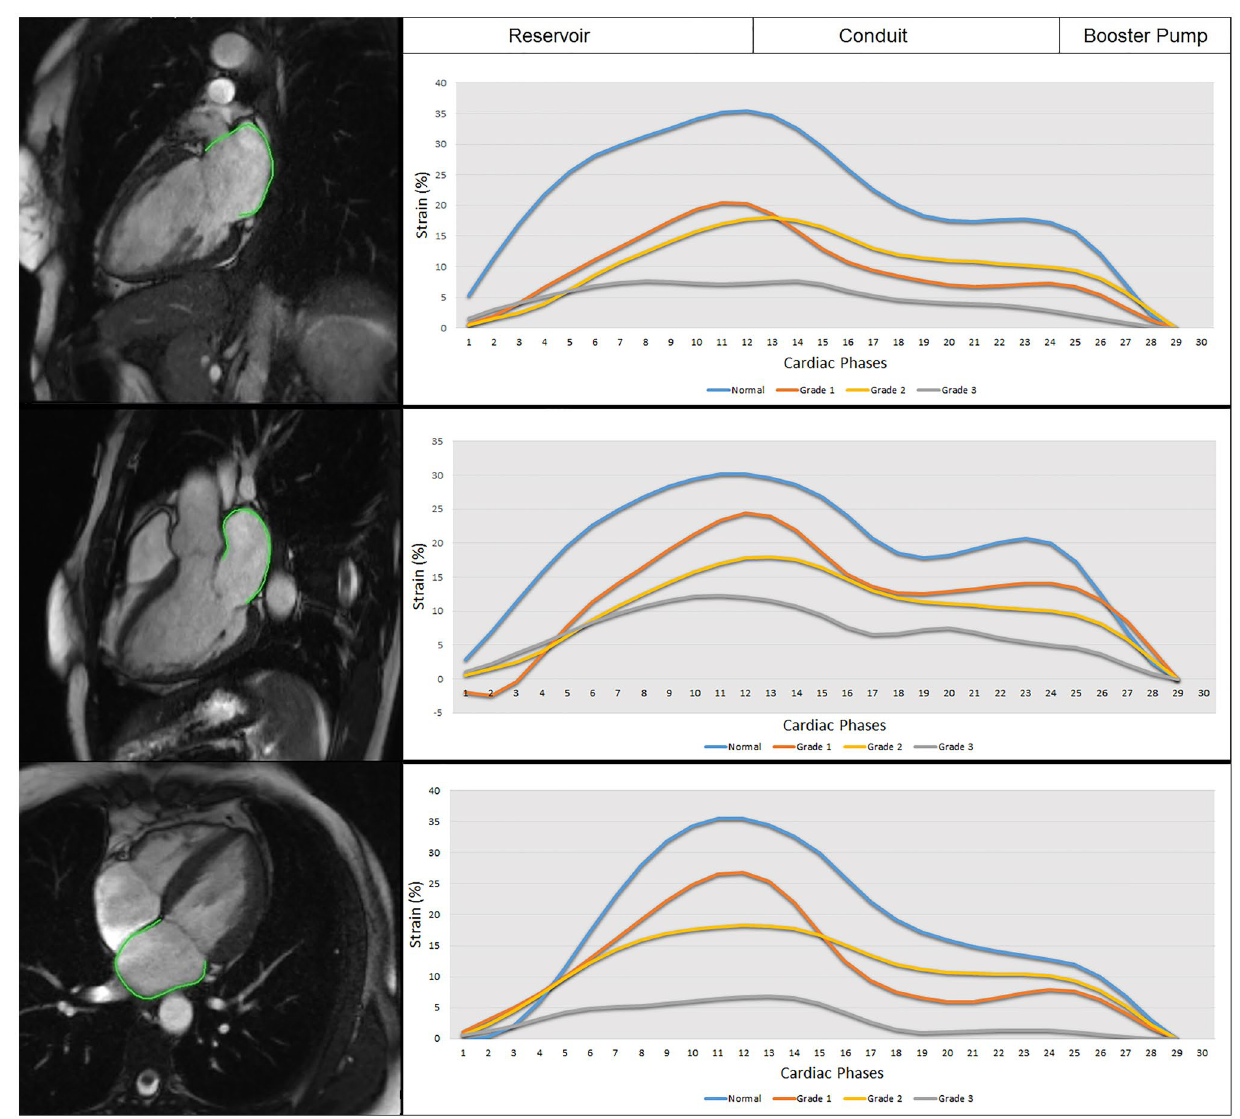
Figure 1. The left panel represents the respective 2-, 3-, 4-, chamber cine views from a normal control subject with the green feature tracking contours overlaying the left atrial wall. The right panels are the corresponding left atrial strain graphs obtained from each view as well as representative strain graphs from subjects with diastolic dysfunction grades 1, 2, and